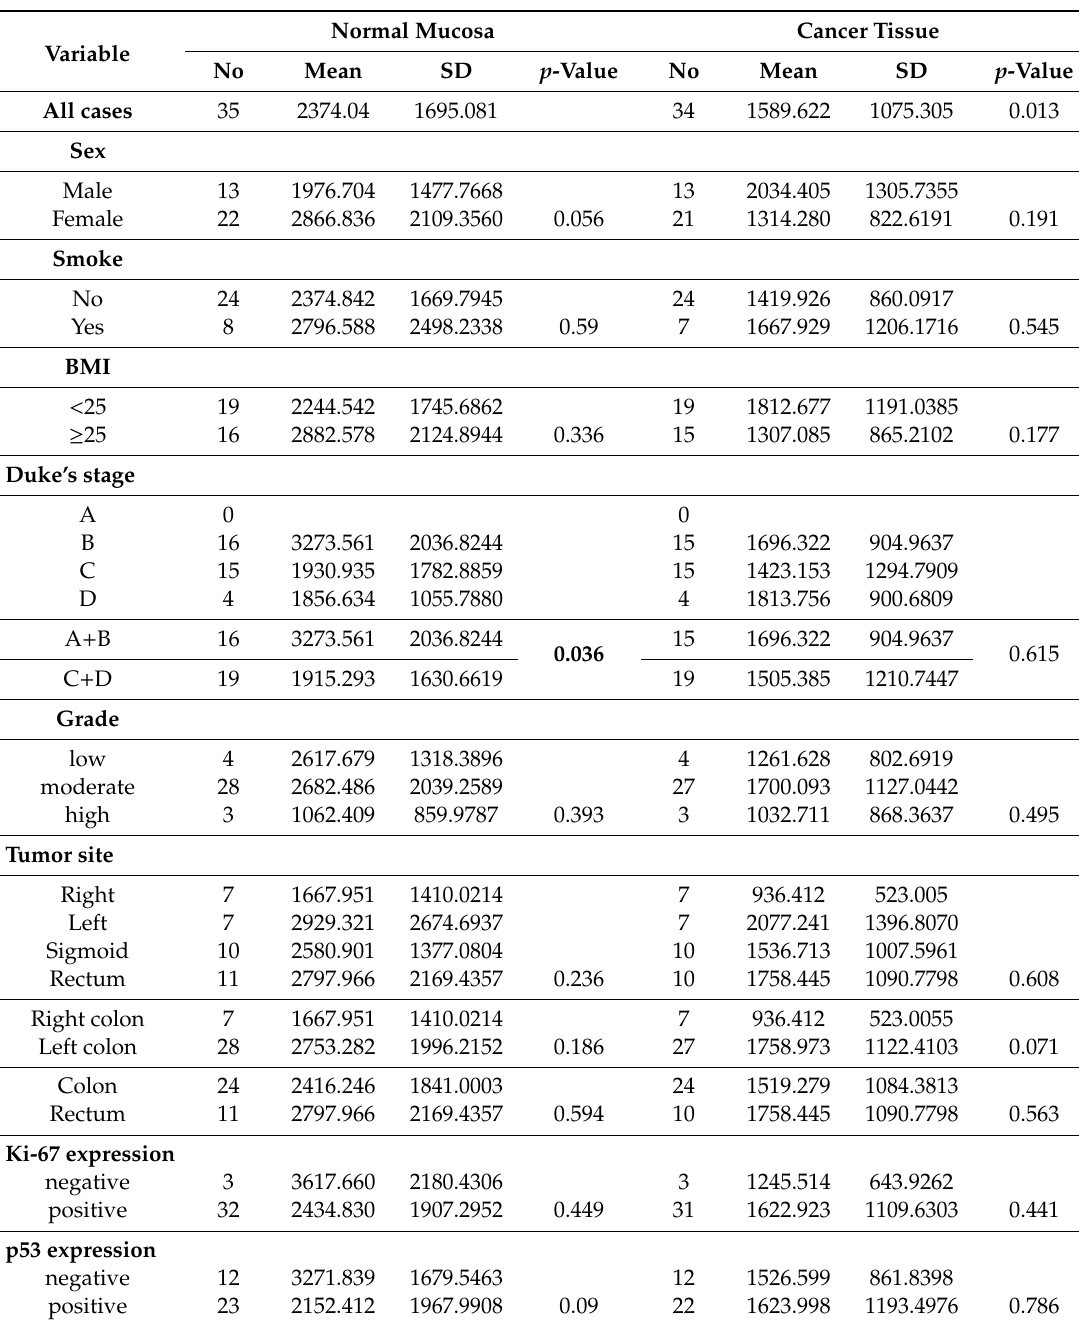
Table 2. PGE 2 levels (pg / mL) in colorectal cancerous tissue and its adjacent mucosa. Colorectal cancer patients have been stratified according to di ff erent clinicopathological characteristics. Statistically significant p -values are highlighted in